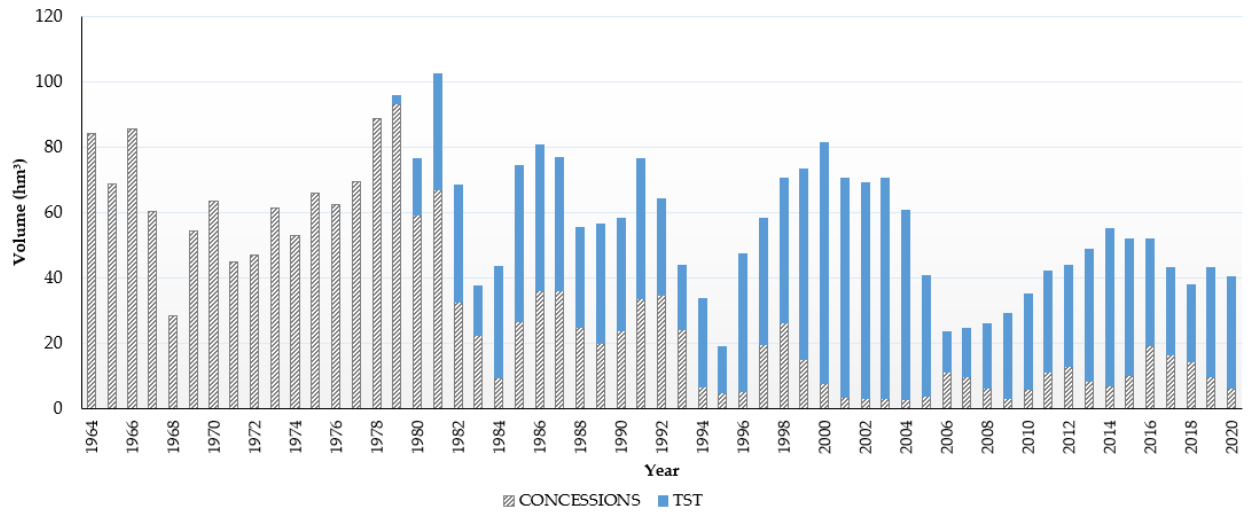
Figure 3. Water distributed by Riegos de Levante, Izquierda del Segura in the last decades.